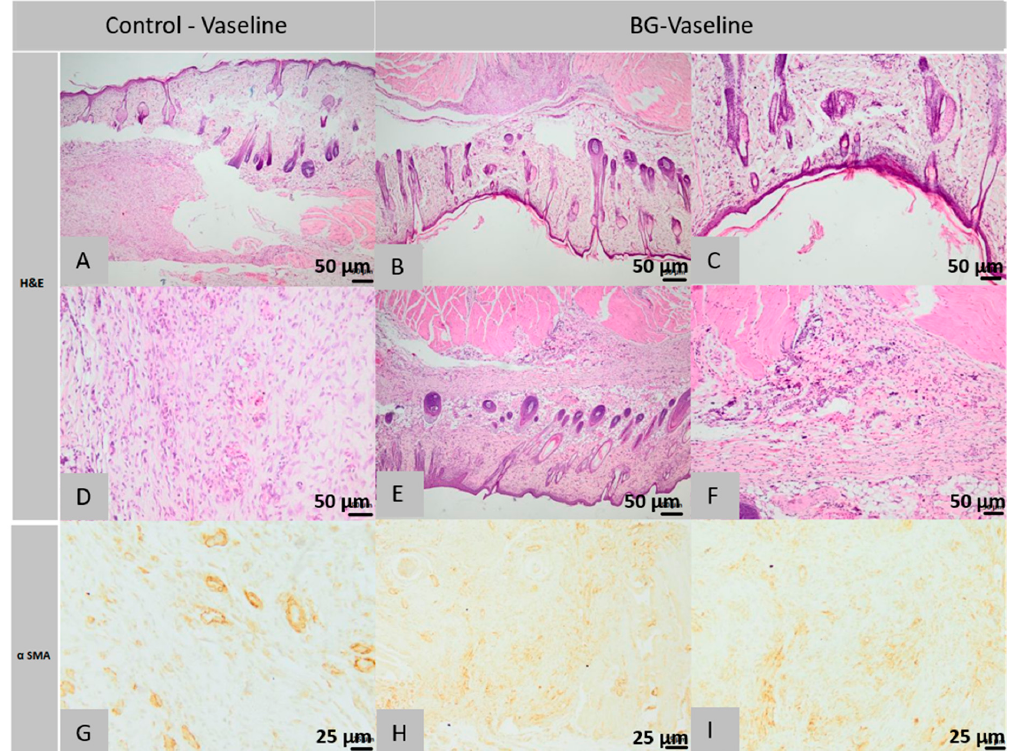
Figure 10. Histopathological images of the skin and subcutaneous tissue from the control animals of the group BG- Vaseline: granulation tissue with few histiocytes ( A ), blood vessels and myofibrils ( A ), abundant granulation tissue, partially oriented ( D ), histiocytes centered around the hair follicle ( D ) (col. HE, ob. 40×). Histopathological images of the skin and subcutaneous tissue from the animals treated with BG-Vaseline: the normal epidermis and collagen fibers in dermis ( B , C ), granulation tissue with blood vessels and myofibers ( E ), the surgical wound completely healed, presence of skin muscle ( F ) (col. HE, ob. 10×), at level superficial dermis fibroblasts, lymphocytes, histiocytes and mast cells, granulation tissue described above contains numerous blood vessels with fusiform cells (myofibroblasts) ( G ), ( H ), scar tissue with blood vessels and fusiform cells ( I ) (col. α SMA, ob. 10×).